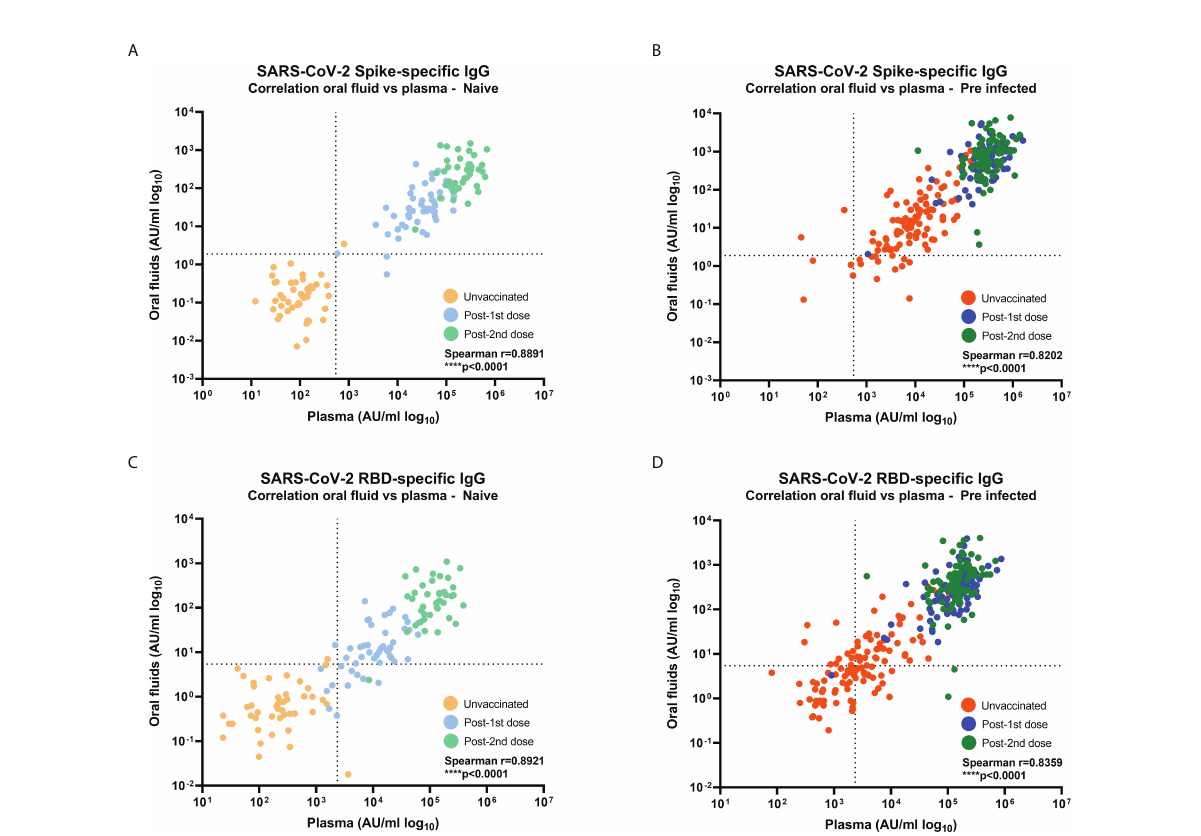
FIGURE 2 Correlations between SARS-CoV-2-speci fi c IgG levels in oral fl uid versus plasma from naïve and previously-infected individuals. Concentrations (AU/ml) of (A, B) S-speci fi c IgG and (C, D) RBD-speci fi c IgG were determined by MSD ® multiplex immunoassay in naïve (A, C) and previously- infected (B, D) HCWs. Pairwise correlations were assessed using Spearman ’ s rank-order correlation. Dashed lines show the cut-offs based on IgG responses in 45 unvaccinated naïve samples (average concentration +